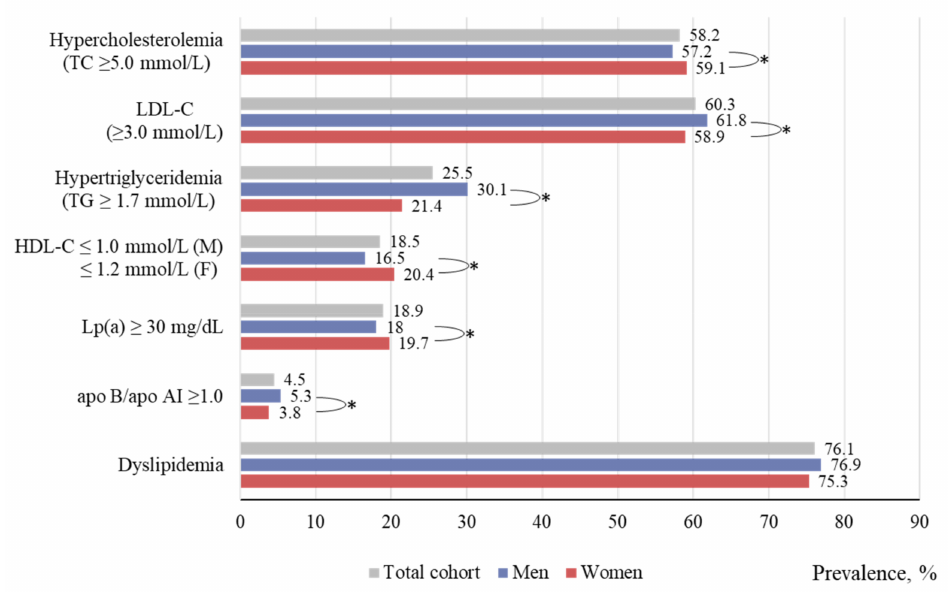
Figure 1. Dyslipidemia prevalence according to ESSE-RF study data. (*) indicates the significant difference between men and women in the corresponding age